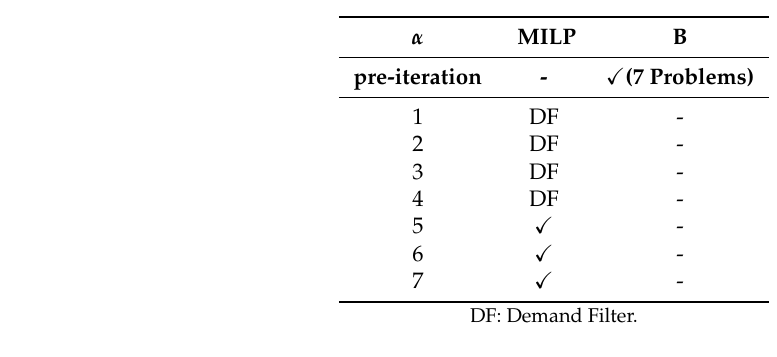
Table 16. Alpha iterations: Scenario